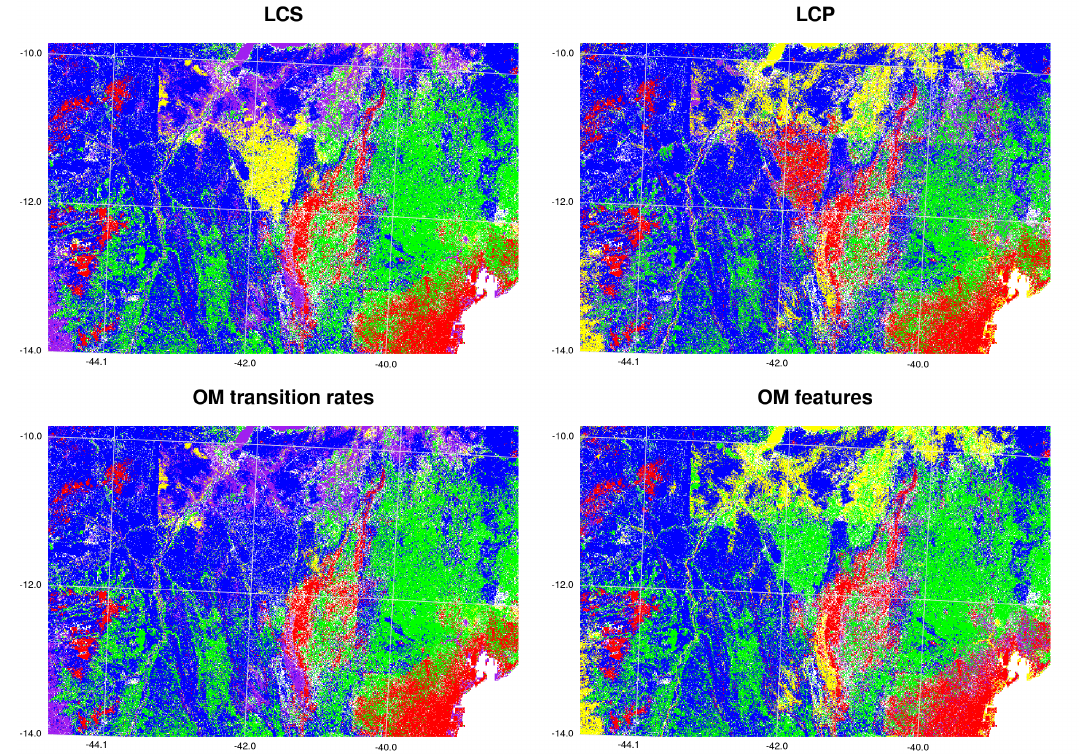
Figure 9. Distribution of clusters obtained through the four types of dissimilarities. Colors were assigned to each cluster in order to enhance similarity between